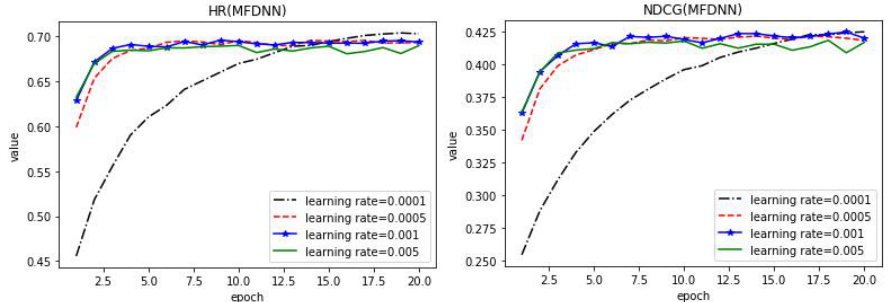
Figure 5. The HR and NDCG values for different learning rates.